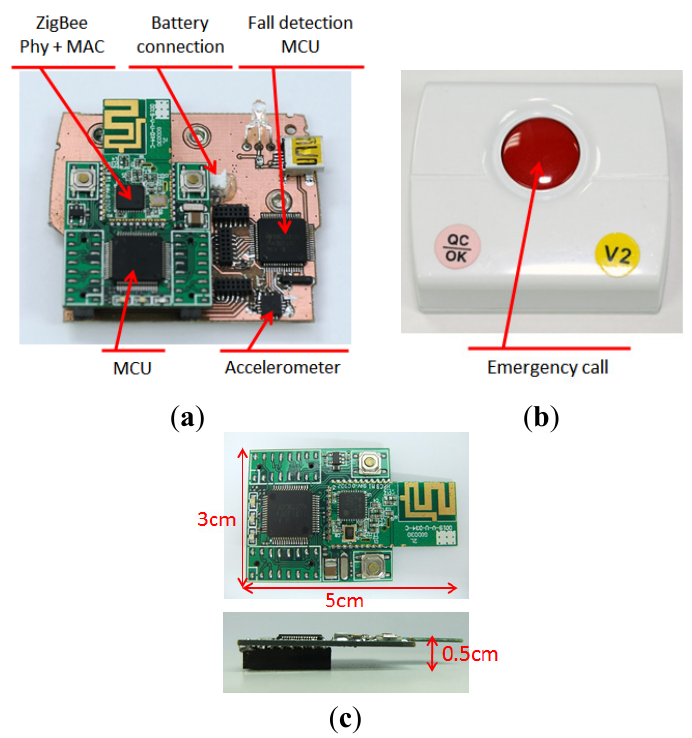
Figure 2. The hardware of wearable sensor and ZigBee module ( a ) The composition of wearable sensor. ( b ) The case of wearable sensor. ( c ) ZigBee